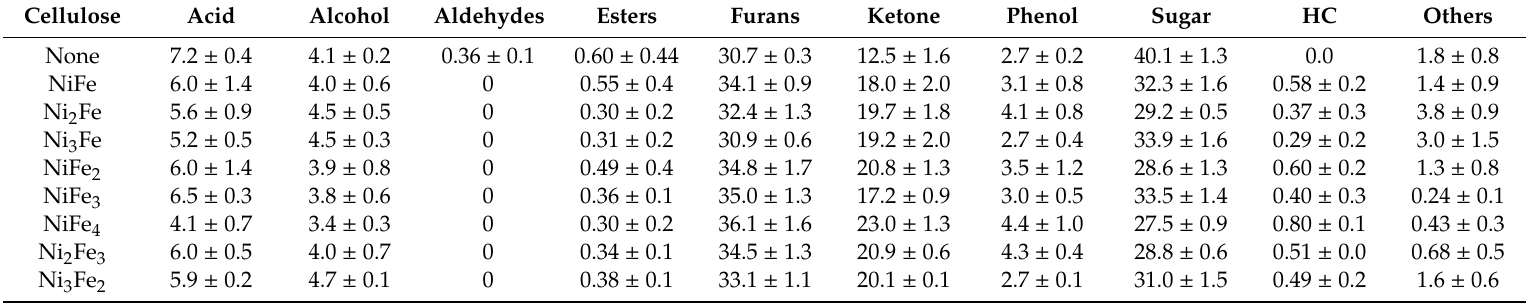
Table 2. Composition of cellulose pyrolyzed products with di ff erent catalysts (peak area% of identified peaks, where HC is hydrocarbon compounds, and unidentifiable compounds are lumped together in others